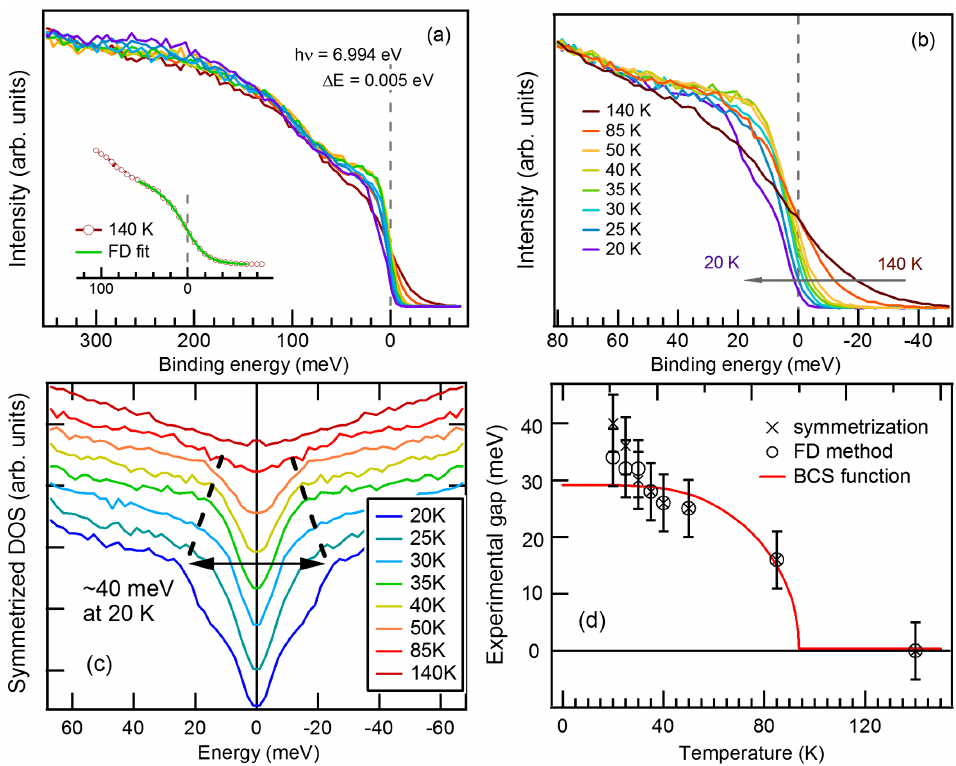
5. Temperature-dependent laser photoemission of K 2 Cr 8 O 16 . (a) T -dependent VB spectra at and near E , obtained using F laser PES. The 0.2-eV feature is evident; the inset shows resolution-convoluted Fermi-Dirac (FD) function fit to the 140-K spectrum confirming a metallic Fermi edge. (b) The spectral intensity at E gets depleted gradually when decreasing T , indicative of a F T -dependent gap formation. (c) DOS obtained upon symmetrizing the VB spectra at each T . (d) The gap vs T shows a BCS-like dependence, suggestive of a second-order phase